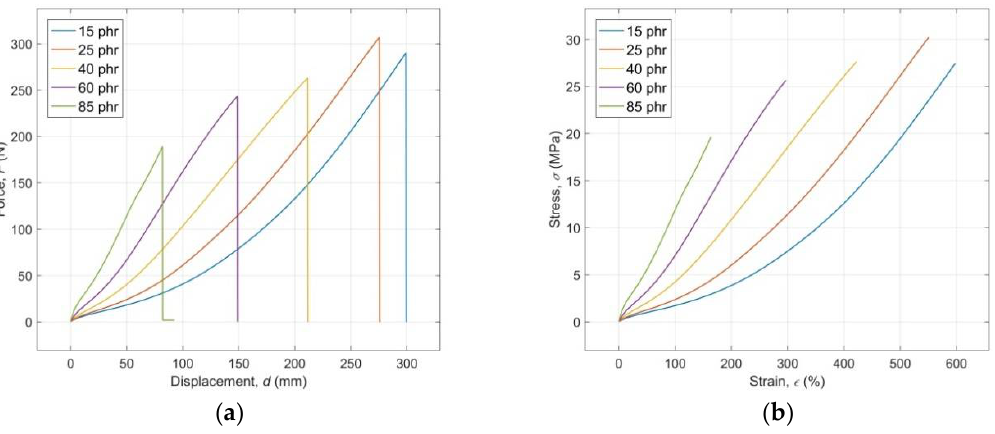
Figure 2. ( a ) Experimental average force versus displacement curves; ( b ) Computed average engineering stress-strain curves.